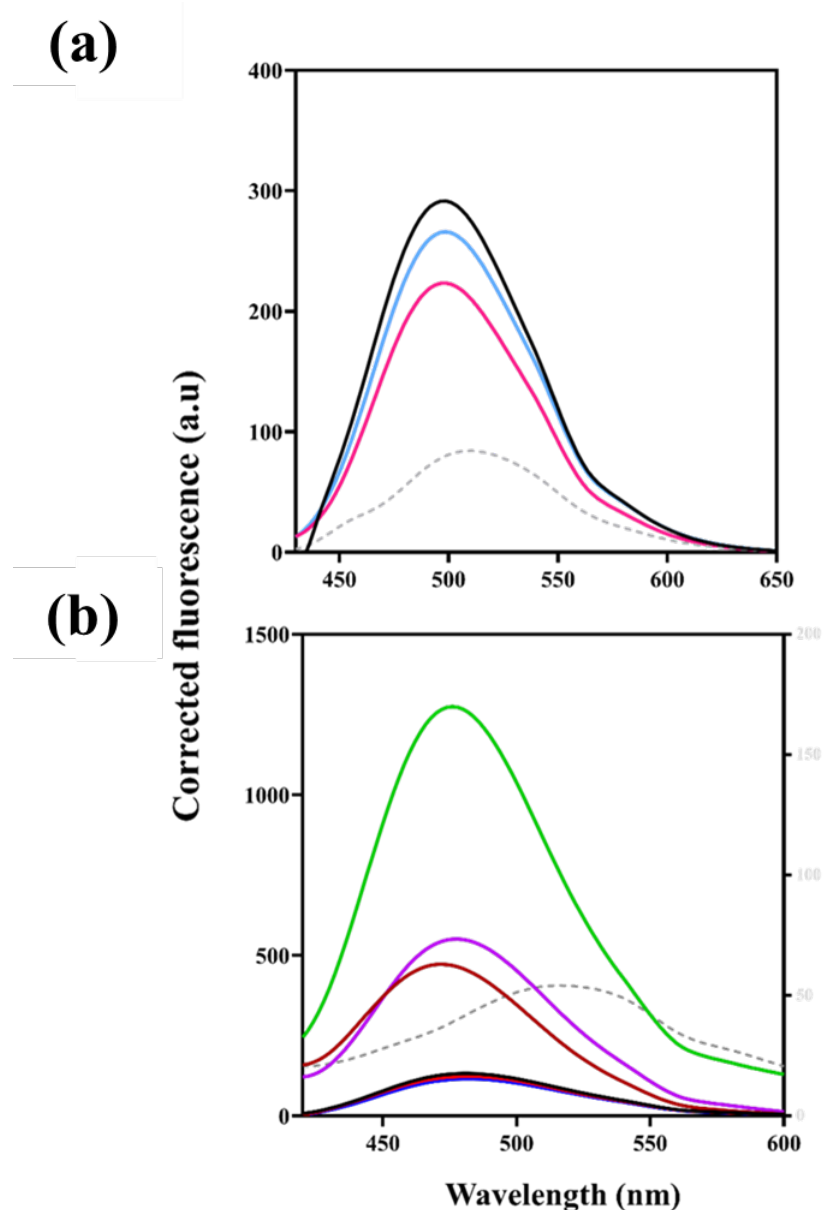
Figure 3. ANS fluorescence emission spectra of KpNNAT. ( a ) in the presence of ATP (pink line), NMN (blue line), and 8 M urea (grey dotted line). ( b ) KpNNAT in the absence of divalent cation (black line), and in the presence of Mg 2+ (blue line), Ca 2+ (red line), Ni 2+ (purple line), Cu 2+ (brown line) and Zn 2+ (green line). The grey dotted line represents the average free ANS in the six conditions. All measurements were performed in 25 mM Tris-HCl, 0.01% (w/v) NaN 3 , pH 7.5 containing 50 µM ANS and 5 µM protein. Excitation was at 395 nm and emission spectra were collected between 400 and 650 nm. The plot was generated using GraphPad Prism.